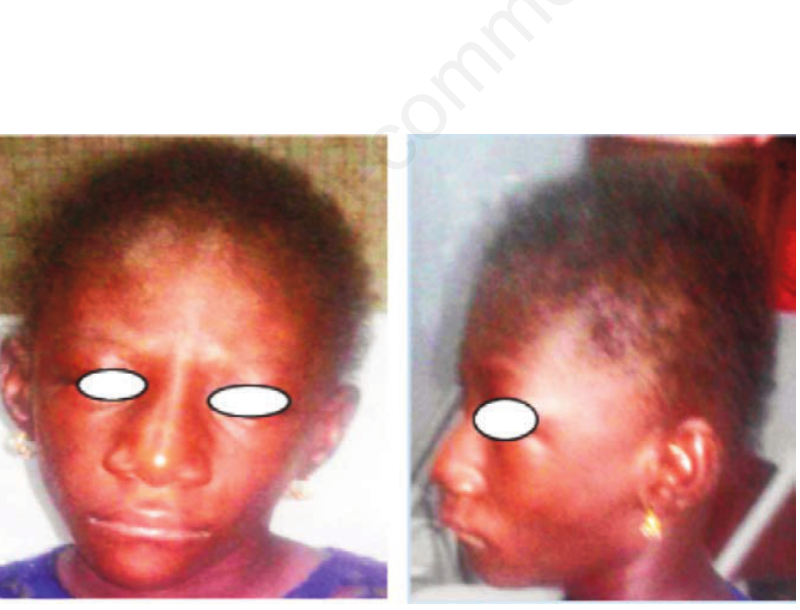
Figure 1. Family tree.